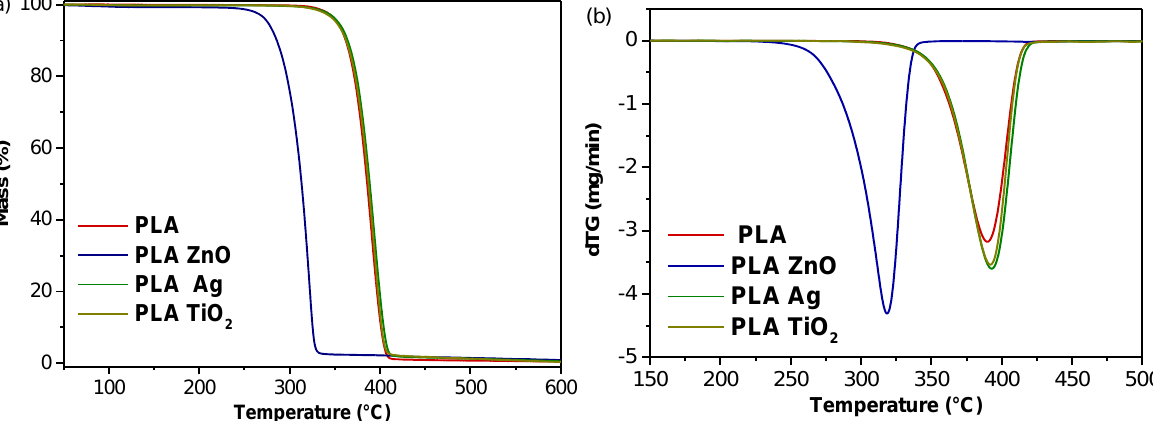
Figure 7. ( a ) Thermogravimetric analysis (TGA) thermograms and ( b ) Derivative Mass loss (dTG) curves of PLA and its nanocomposites.